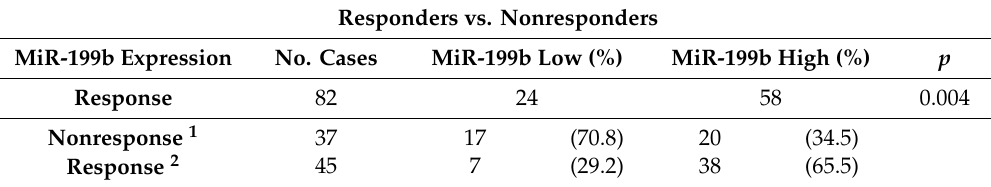
Table 2. Association between miR-199b expression levels and pathological response to neoadjuvant CRT in LARC